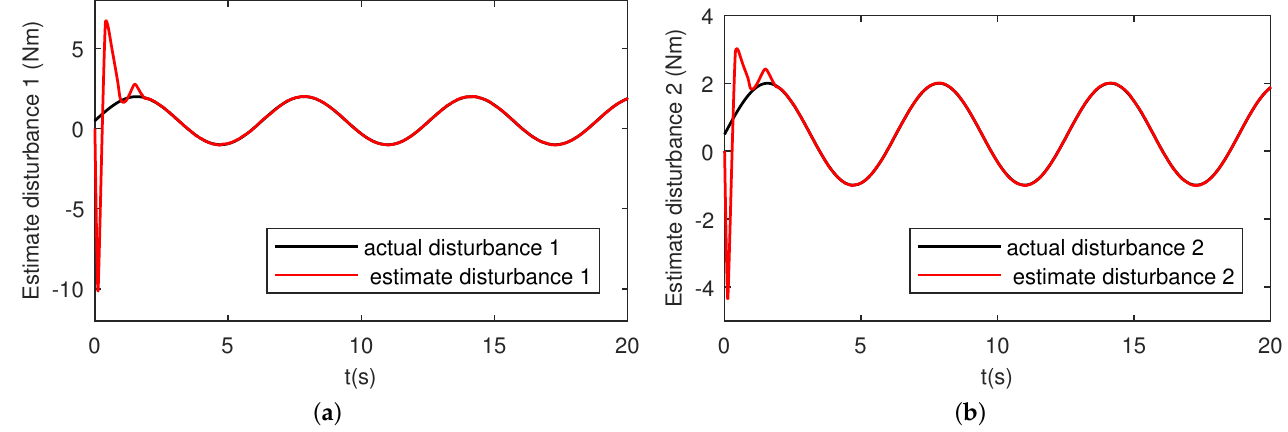
Figure 6. Disturbance estimations: ( a ) Link 1. ( b ) Link